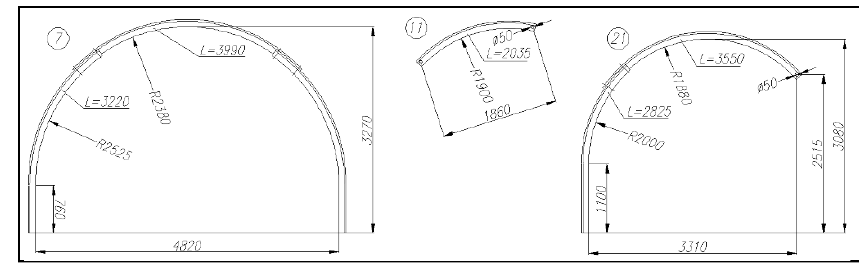
Figure 19. The structure of the branch casing-portal and cantilever.